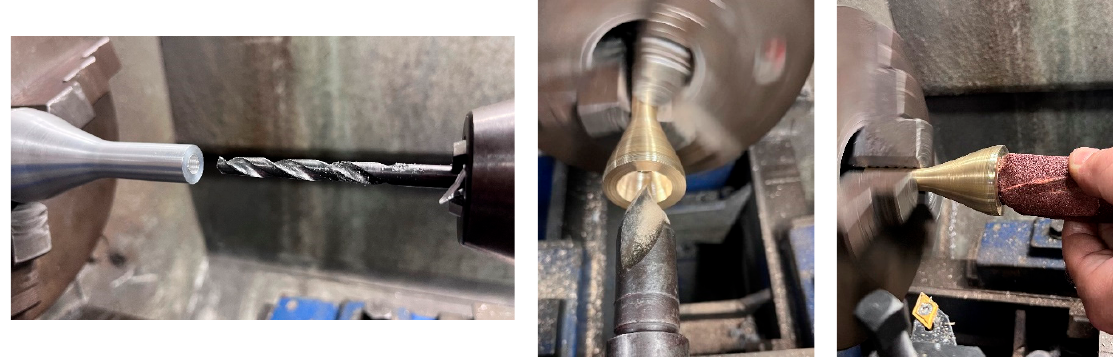
Figure 6. Internal drilling and sanding of the throat on a Pinacho S-90/200 manual lathe.